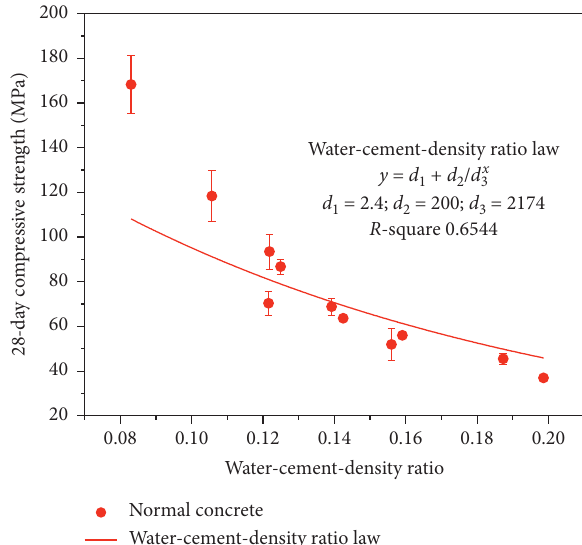
Figure 4: Simulation of water-cement-density ratio law for normal concrete.